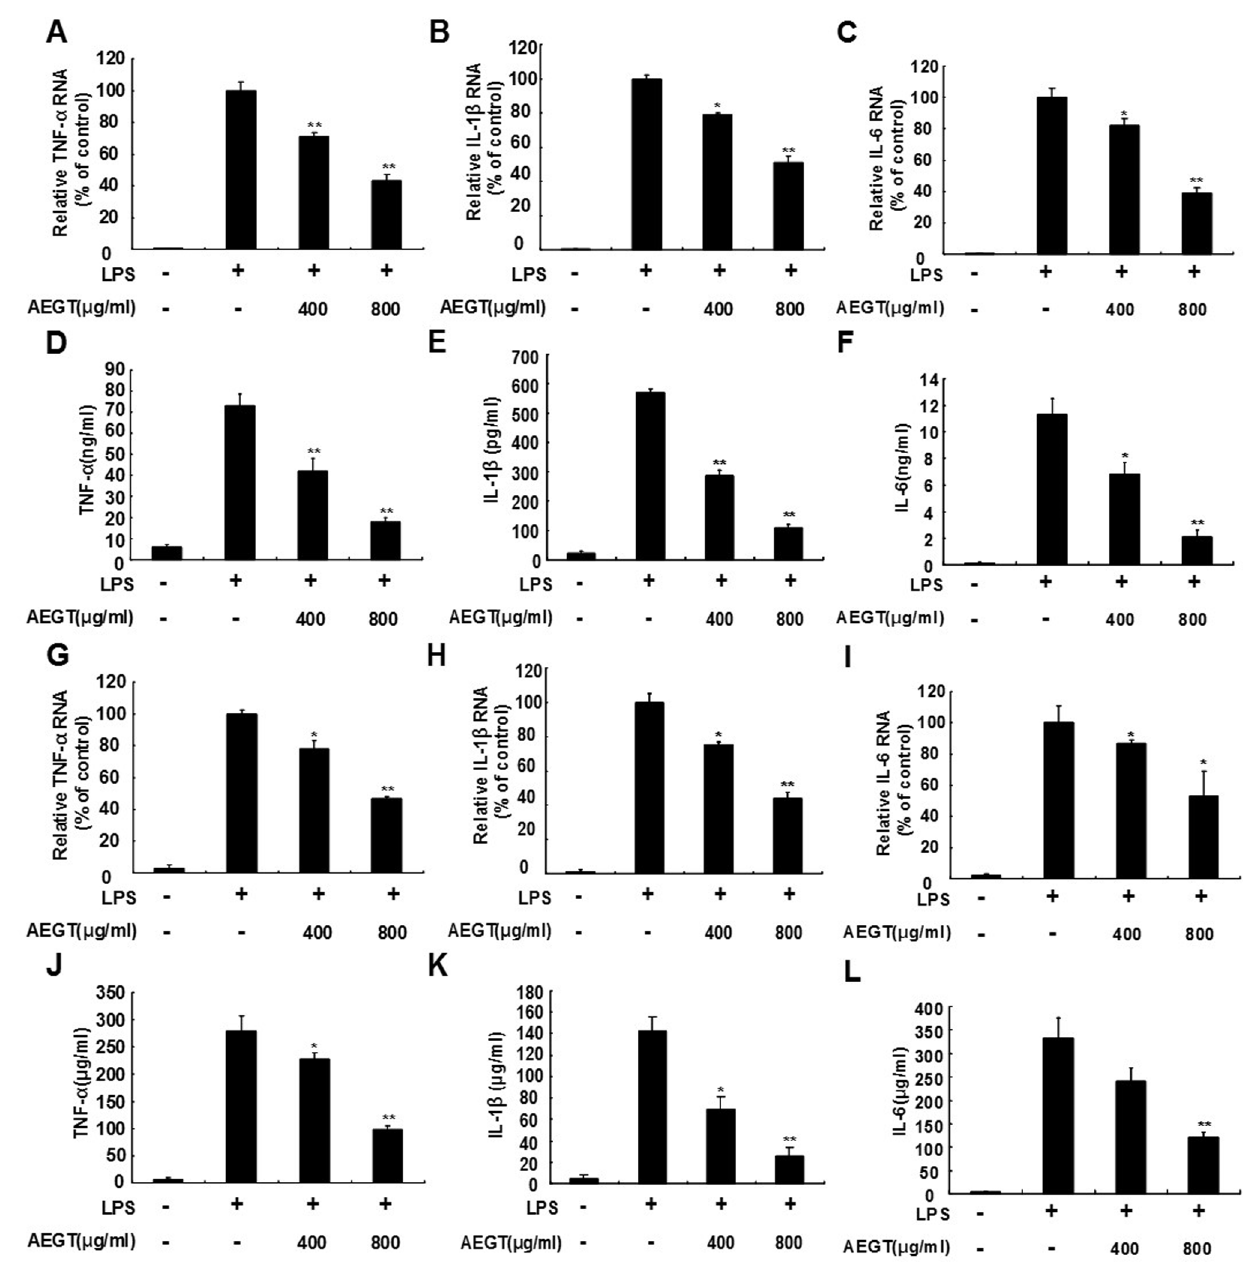
Figure 3. Effect of AEGT on the production and gene expression of proinflammatory cytokines in LPS-stimulated RAW 264.7 cells (A–F) and primary rat peritoneal macrophages (G–L). Cells were seeded in a 24-well plate treated with 400 or 800 m g/ml AEGT for 1 h, and then incubated with 1 m g/ml LPS for 24 h. The RNA (A–C and G–I and secreted protein levels of proinflammatory cytokines including TNF- a (D and J), IL1- b (E and K) and IL6 (F and L), were analyzed by qRT-PCR and ELISA, respectively. The efficiency of inhibition was determined as the percent RNA levels relative to those in the cells treated with LPS alone. Error bars indicate the means 6 SD of three independent experiments. * P , 0.05; ** P , 0.01.